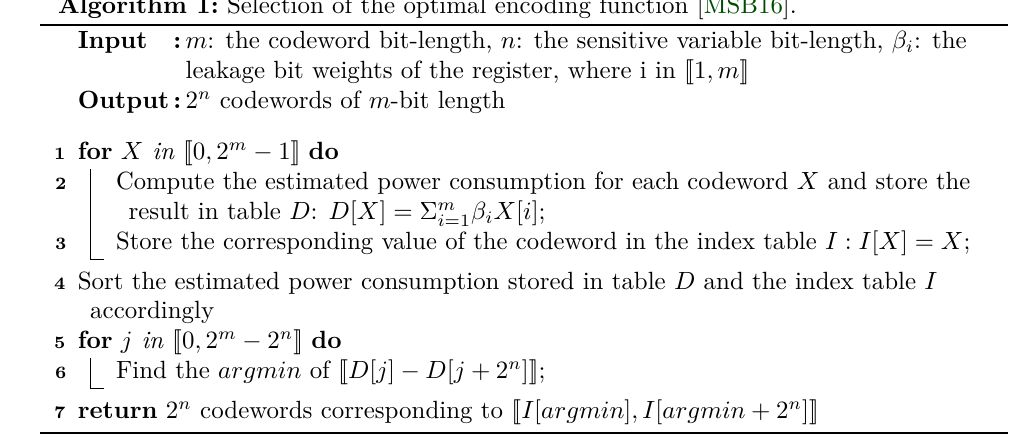
Algorithm 1: Selection of the optimal encoding function [MSB16].